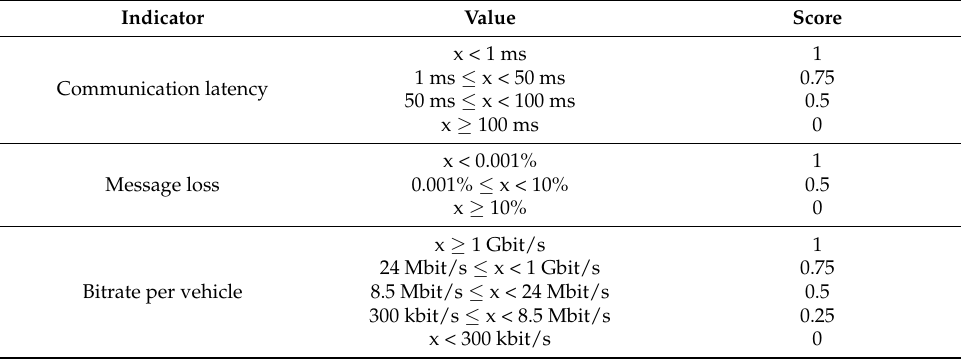
Table 1. The assessment framework—connectivity area.